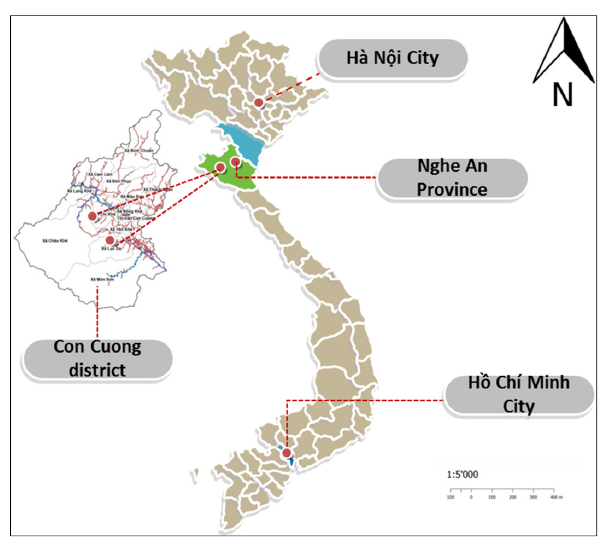
Figure 1. Location of the study sites in Luc Da and Chi Khe communes.